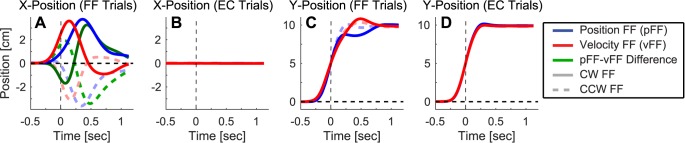
Hand displacement during velocity-dependent and position-dependent single trial learning.The average perpendicular (X-axis) displacement of the hand path (along the x-axis) as a function of time for (A) force-field (FF) and (B) error-clamp (EC) trials. The blue and red traces represent position-dependent force-field (pFF) and velocity-dependent force-field (vFF) perturbations respectively. The green traces represent the difference between the blue and red traces. Clockwise (CW) FF data are illustrated with bright solid lines, and counter-clockwise (CW) FF data are illustrated with lighter dashed lines. Longitudinal (Y-axis) hand paths are shown as a function of time for (C) FF and (D) EC trials. Zero ms in all panels corresponds to the midpoint of the movement.